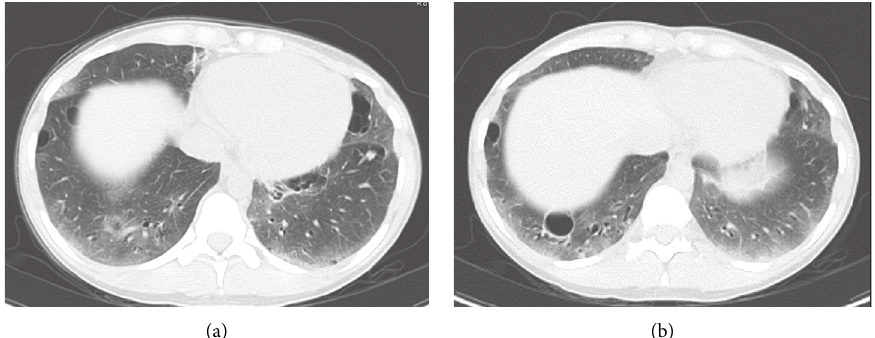
Figure 4: High-resolution computed tomography of the chest (Case 3). The scan prior to our evaluation (a) demonstrated pulmonary nodules, thin-walled cysts, basilar predominant ground glass attenuation, and subpleural consolidation consistent with lymphocytic interstitial pneumonia (LIP) in the setting of Sj¨ogren’s syndrome. A repeat scan (b) demonstrated increased ground glass attenuation and stable thick-walled cysts, and a few of the bilateral solid pulmonary nodules had slightly increased in size.